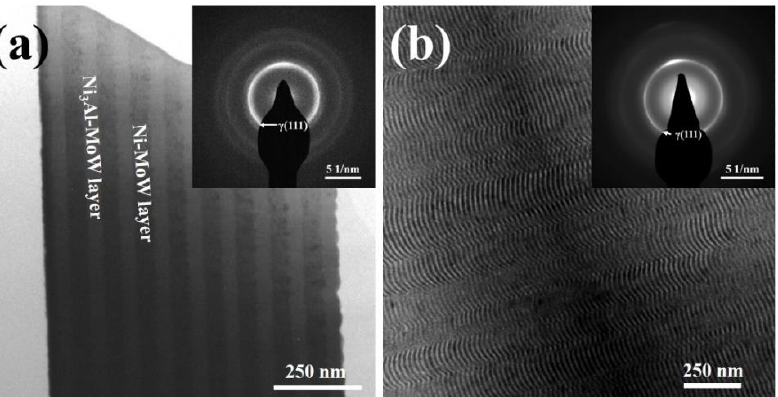
Figure 5. The representative cross-sectional bright fields (BF) TEM image: ( a ) h = 40 nm; ( b ) h = 10 nm, and corresponding selected area electron diffraction results of Ni/Ni 3 Al-MoW multilayers are shown in the inset.